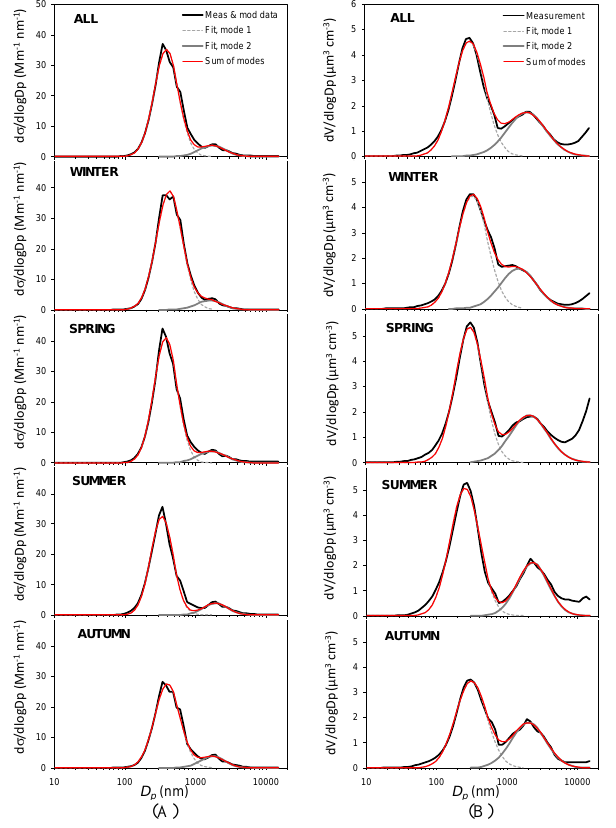
Fig. 10. Average size distribution of σ SP and aerosol volume con- centration and to the average size distributions fitted two lognormal modes and their sum in four seasons. Left: dσ SP /d log D p ; right dV/d log D p .